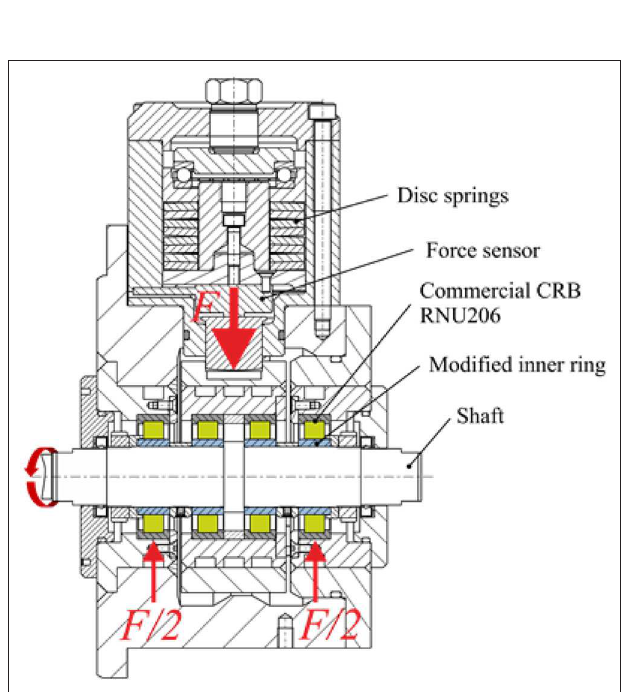
FIGURE 2 | Hybrid process tool for turn-rolling.